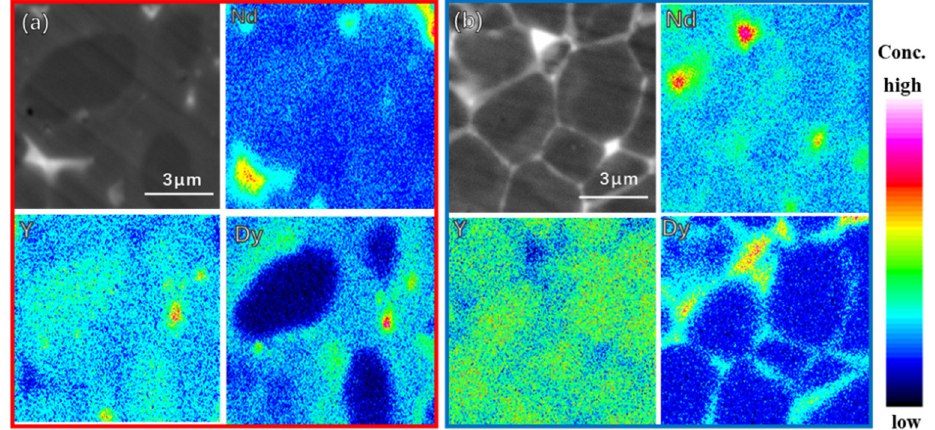
Figure 4. EPMA elemental mappings of the DyH x addition magnet ( a ) and the DyH x diffusion magnet ( b ).